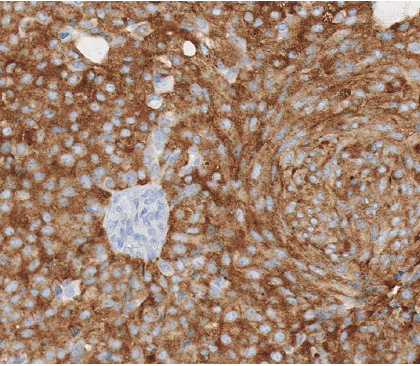
Figure 4: Positive synaptophysin